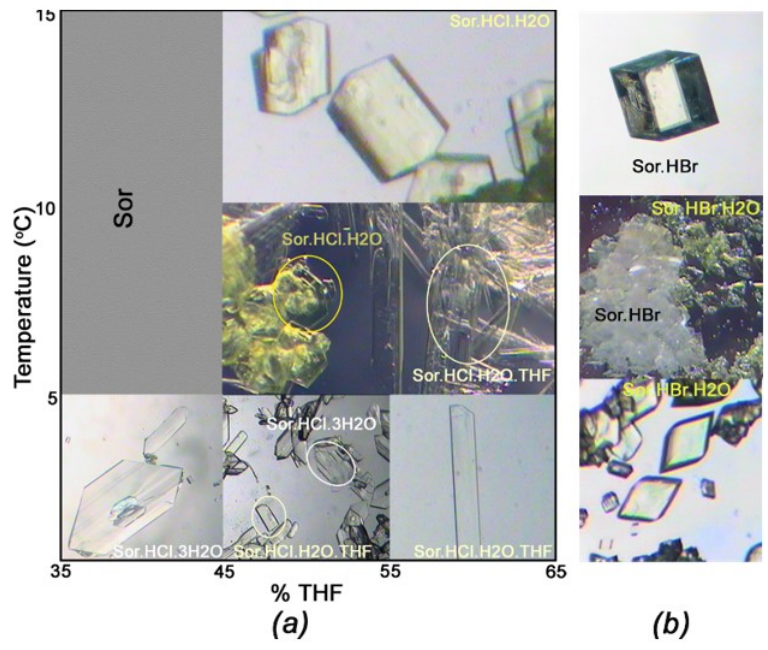
Figure 1. The optical micrographs of ( a ) (I)–(III) crystallized forms in different %THF and temperature conditions, ( b ) (IV) and (V) crystallized